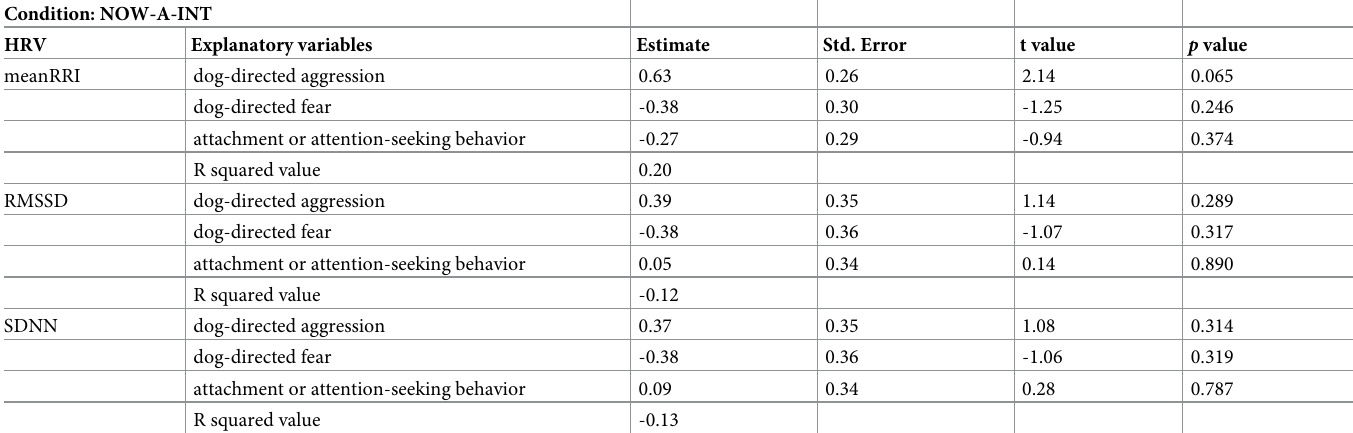
Table 2. Parameter estimates for the relationship using HRV data as the dependent variable and CBARQ scores as the explanatory variable in the NOW-A-INT condition. Condition: NOW-A-INT